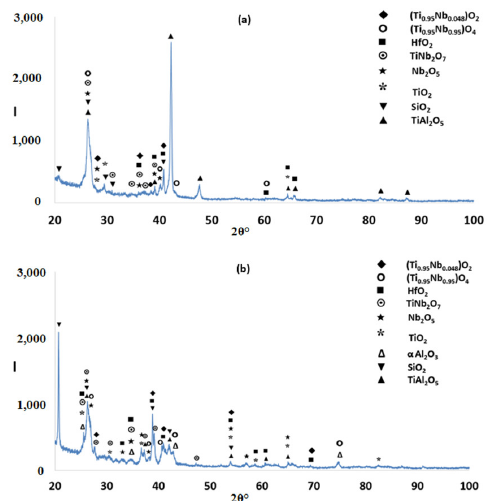
Figure 16. Glancing angle X ray diffractograms ( θ = 5 ◦ ) of the alloy Nb 1.3 Si 2.4 Ti 2.4 Al 3.5 Hf 0.4 after isothermal oxidation ( a ) at 800 ◦ C; ( b ) at 1200 ◦ C.